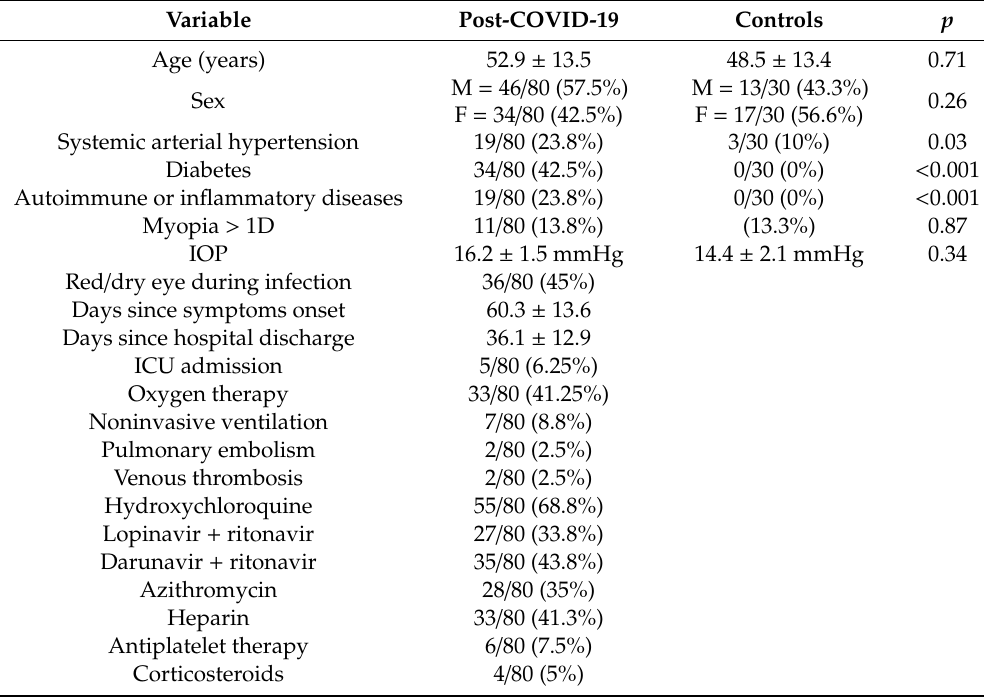
Table 2. Descriptive analysis of the study groups. IOP values are the mean of three measurements performed at the time of the study examination. Drugs are intended as administered during